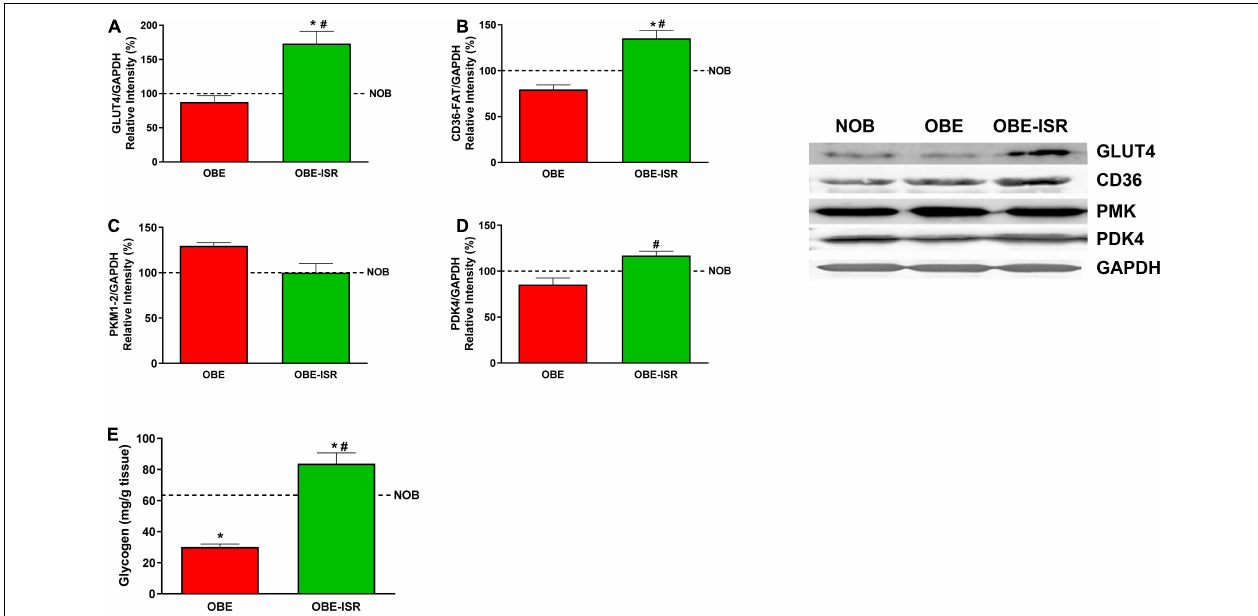
FIGURE 6 | Uptake and metabolism of glucose and fatty acids in the muscle. (A) GLUT4. (B) CD36-FAT. (C) PKM1/2. (D) PDK4. (E) Glycogen. Rats were fed a normal rodent diet (NOB) or a high-fat diet (HFD) formulated with rapidly (OBE) or with slowly digestible carbohydrates (OBE-ISR). Data expressed as mean ± SEM. *Significant difference with NOB group, p < 0.05. #Significant difference with OBE group, p <